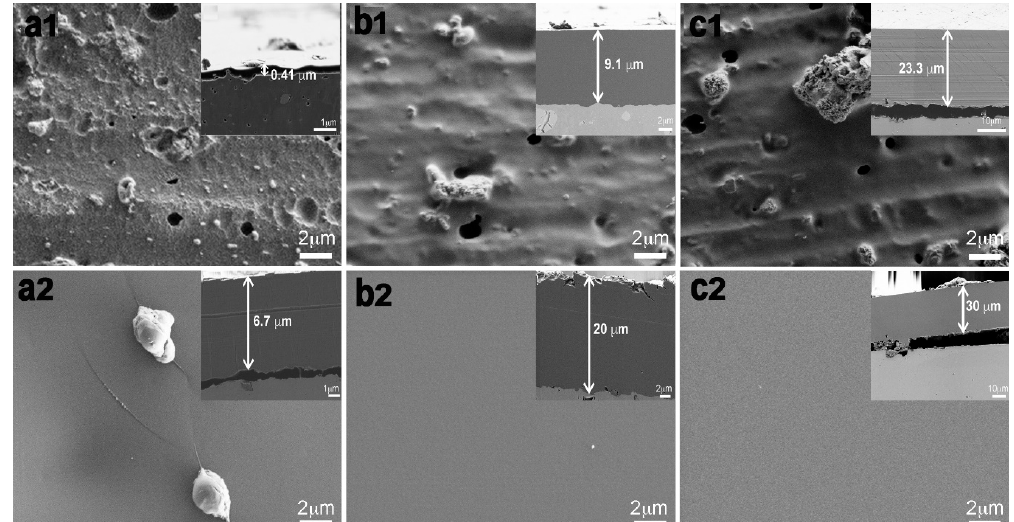
Figure 3. SEM micrographs and cross-sections of the AA2024 alloy coated by radical polymerization treatment, without pseudo-transesterification; ( a1 ) AA-PMMA 45 ′ ; ( b1 ) AA-PMMA 90 ′ ; ( c1 ) AA-PMMA 120 ′ and with pseudo-transesterification; ( a2 ) AA-PMMA 45 ′ ; ( b2 ) AA-TE-PMMA 90 ′ ; and ( c2 ) AA-TE-PMMA 120 ′ .